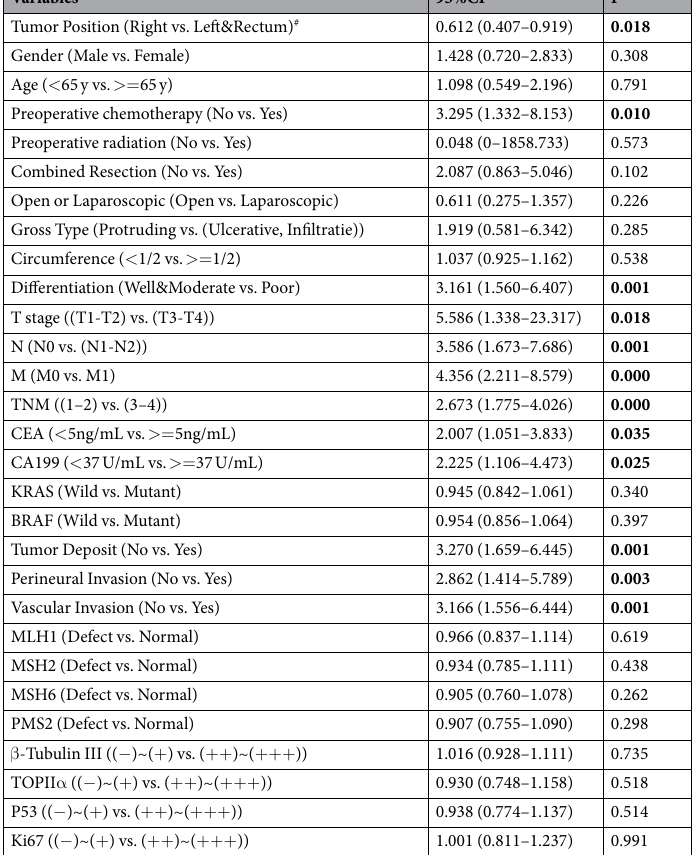
Table 5. Univariate Analyses of Factors Associated With Progression Free Survival (n = 289). # Right-sided colon cancer vs. Left -sided colon cancer & Rectal cancer.